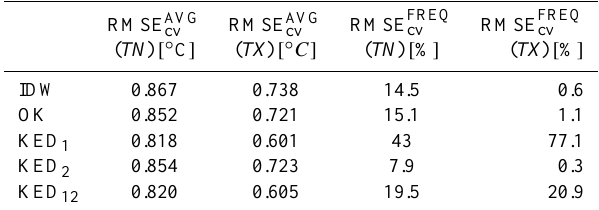
Table 4. Overall performance of the different interpolation methods over the entire time period expressed in terms of RMSE AVG cv and RMSE FREQ cv for both TX and TN .